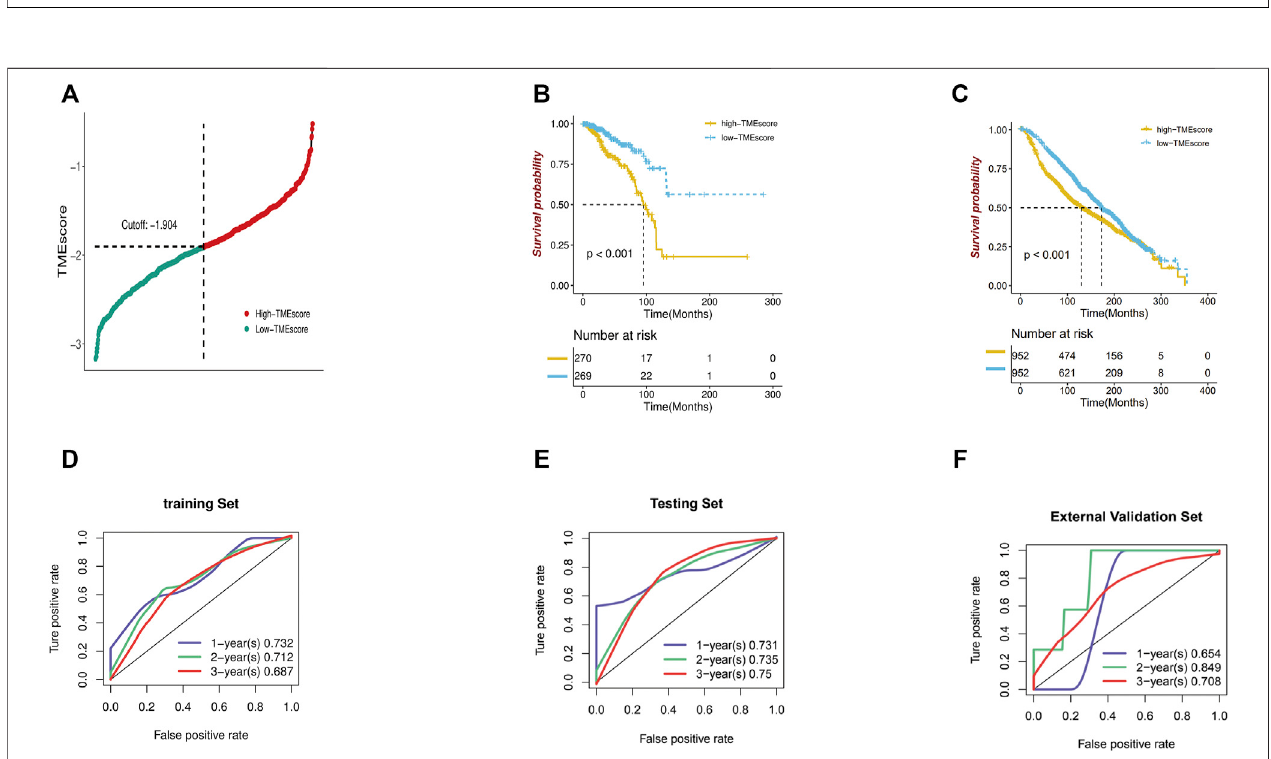
FIGURE 4 | (A – C) The TME score and Kaplan-Meier curve analysis of seven immune-associated gene signature in TCGA-BRCA and METABRIC cohort. (D – F) ROC curves measuring the predictive values of the TME score at 1, 2, and 3 years in overall, training and external validation set, respectively.